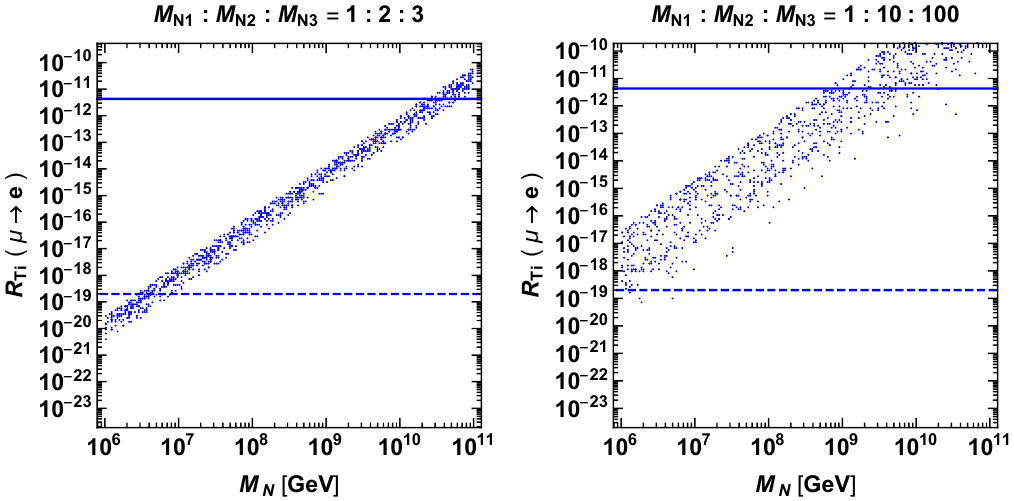
Figure 9 . R Ti ( µ → e ) is shown for the model B . The parameters are same as figure 7.